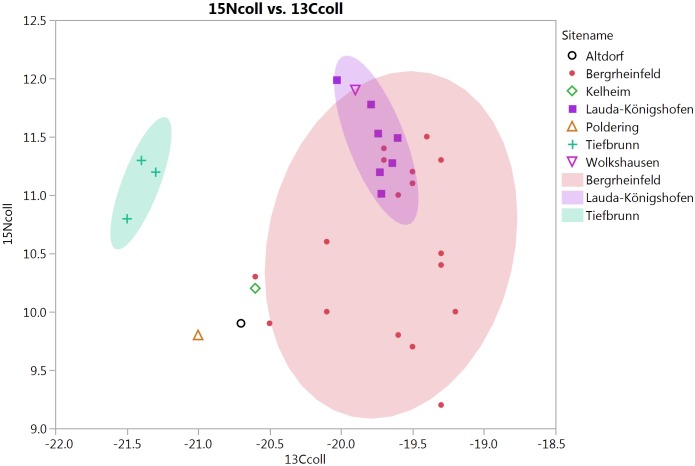
Scatterplot of δ 15N vs. δ 13C for all samples.